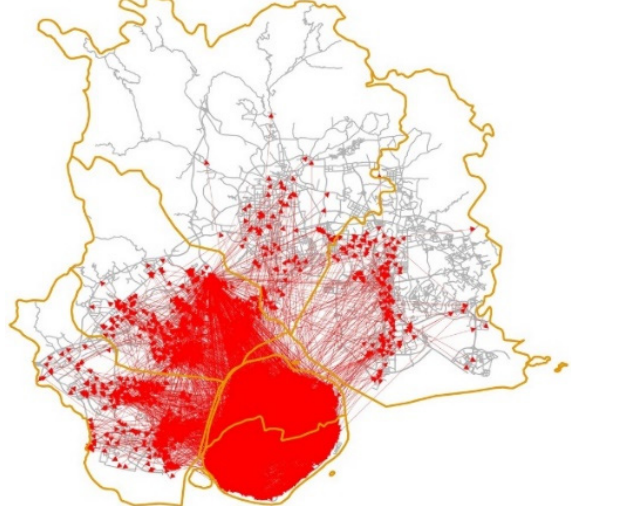
Figure 6. Study area.